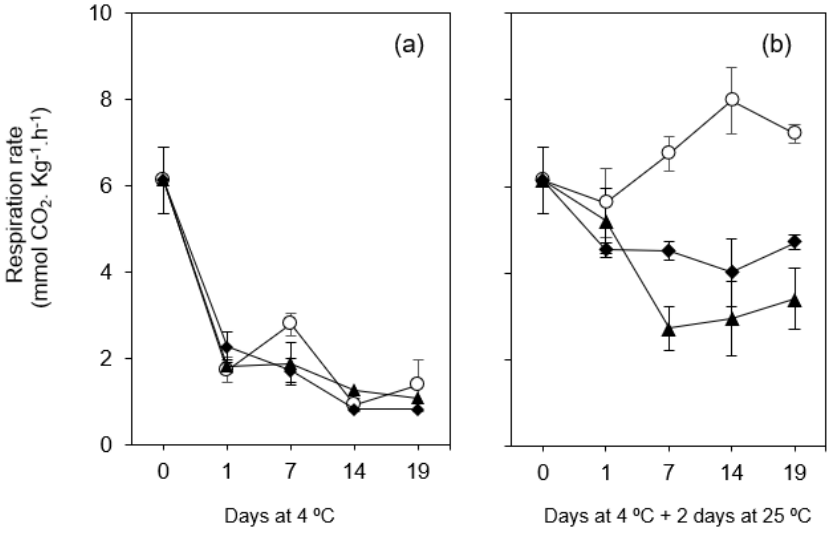
Figure 3. Respiration rate of fresh figs ( Ficus carica L. var. ´ Pingo de mel ´ ) coated ( (cid:117) C-OO-TPP and (cid:115) A-OO-Ca) and uncoated ( Ctr), under refrigeration over 19 days at 4 ◦ C ( a ) and after being transferred to room temperature for 2 days ( b ). Each symbol represents each experimental condition, which is associated to a line.